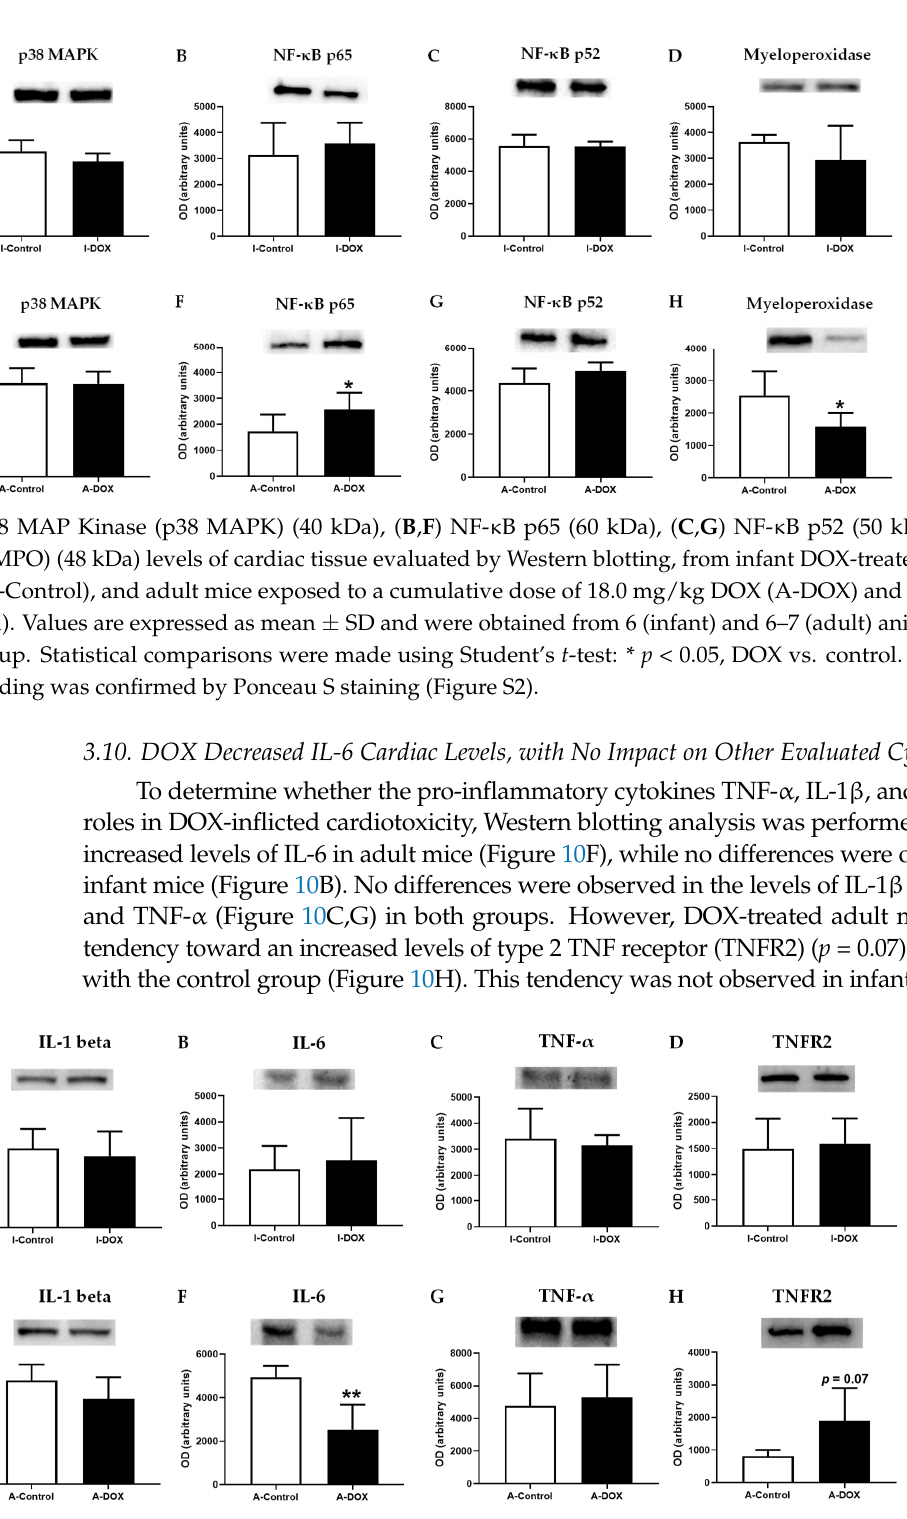
(TNF- α ) (25 kDa), ( D , H ) type 2 TNF receptor (TNFR2) (75 kDa) levels in cardiac tissue evaluated by Western blotting, in